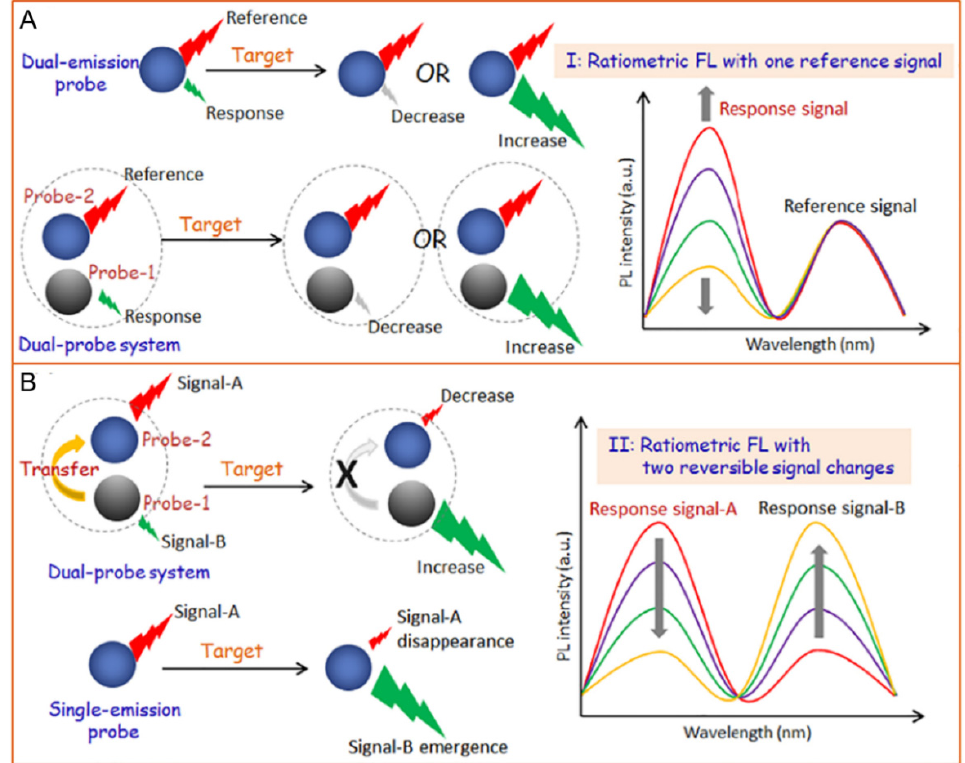
Figure 1. The general categories for fabricating dual-emission ratiometric fluorescent sensors. Ratiometric fluorescence with one reference signal ( A ) or with two reversible signal changes ( B ). Reproduced from [1], with permission from Elsevier, 2019.